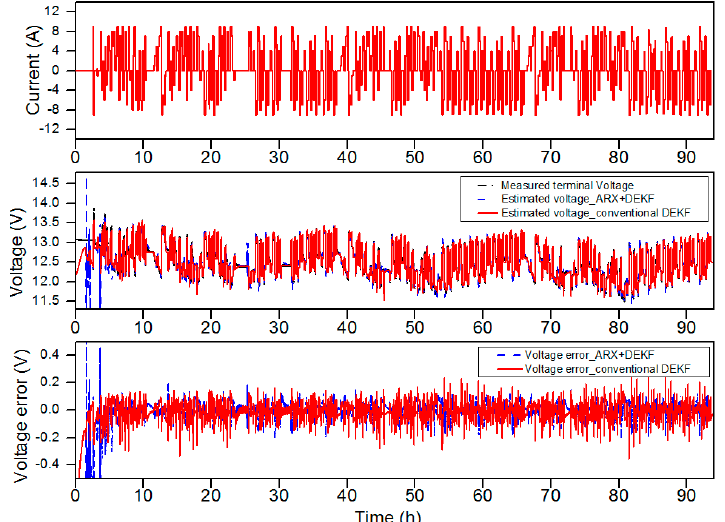
Figure 3. Current profile ( upper graph), measurement voltage and estimated voltage comparison ( middle graph) and voltage estimation error ( lower graph).